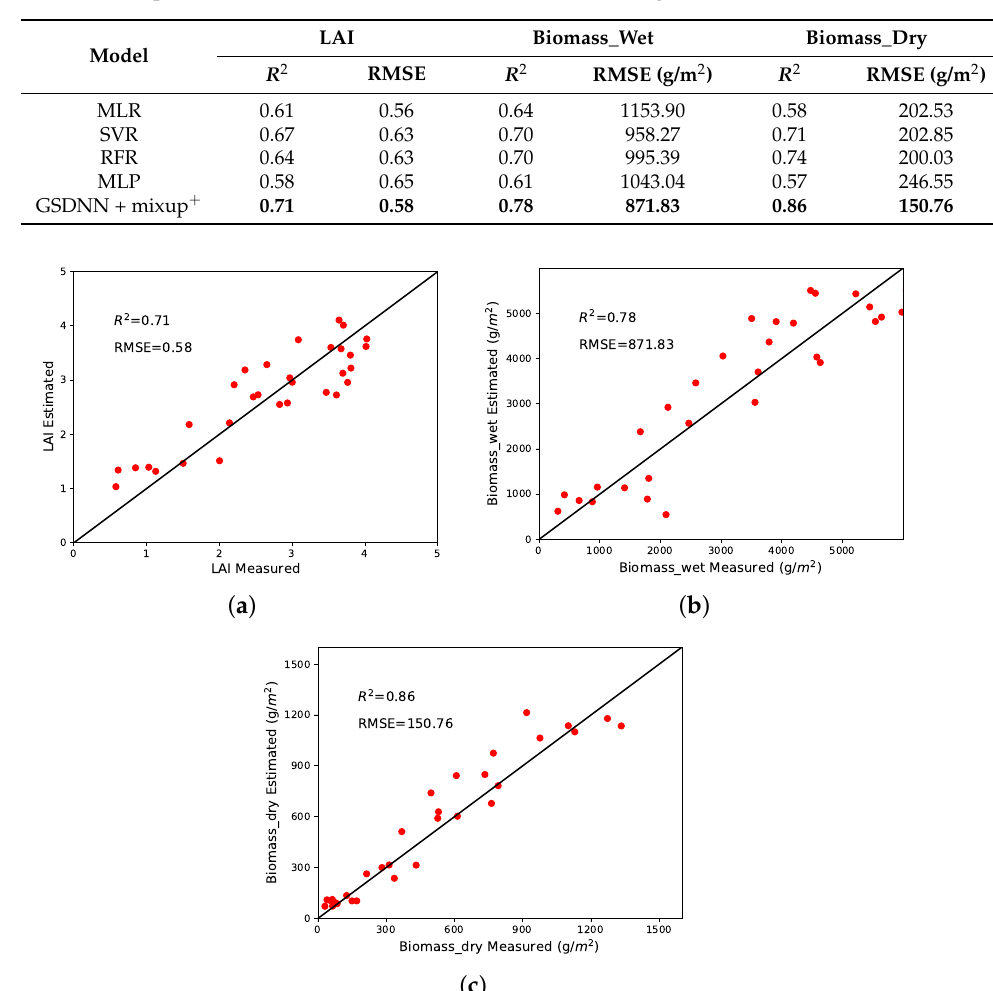
Table 3. Comparison of the GSDNN with other machine learning methods.